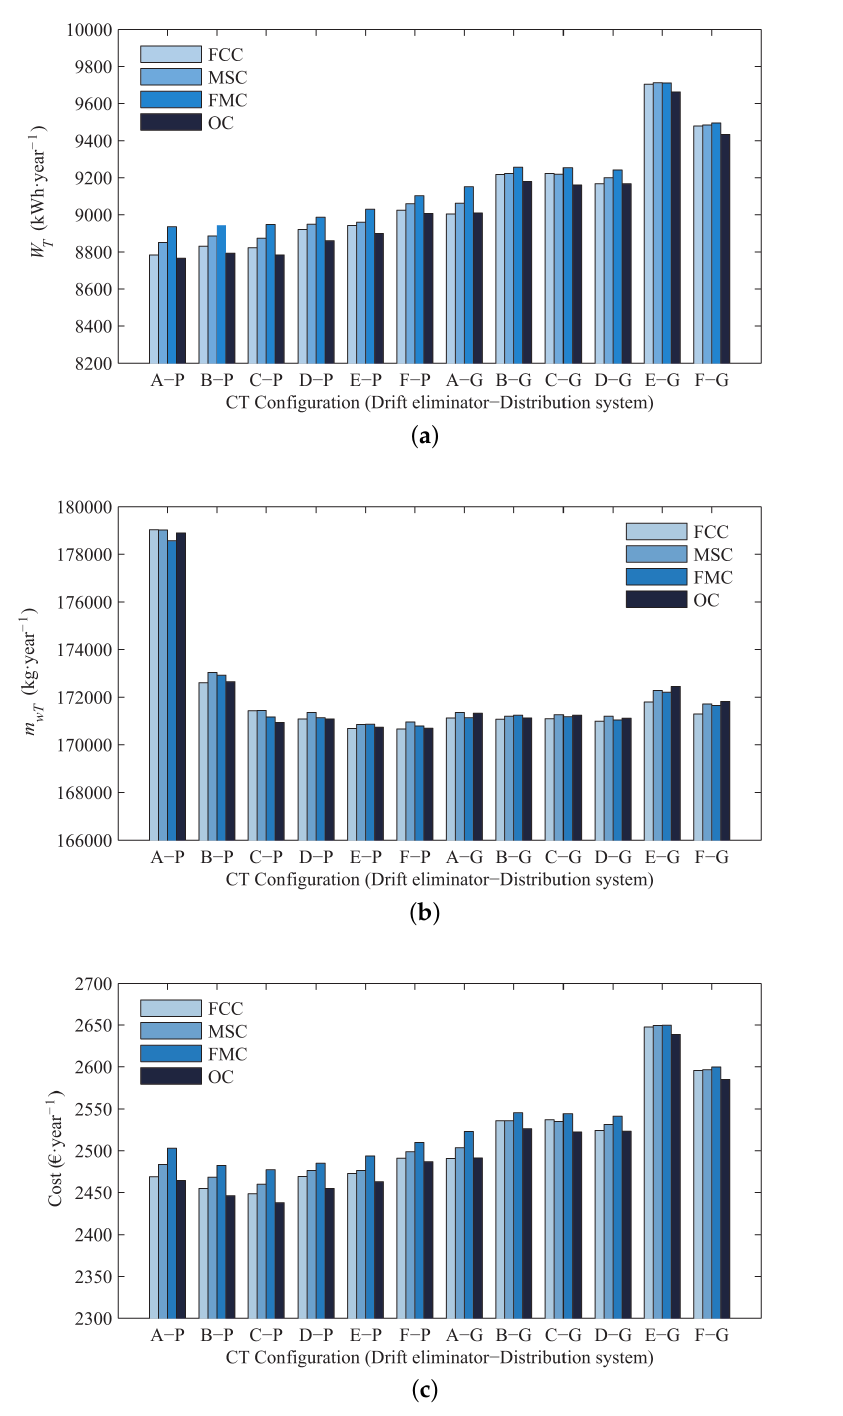
Figure 10. Energy consumption ( a ), water loss ( b ) and cost ( c ) for each